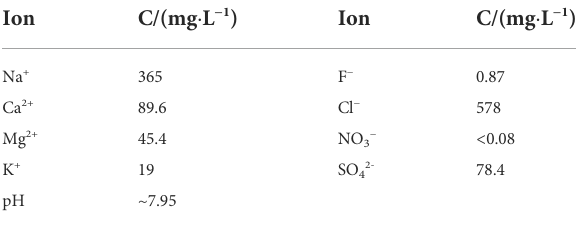
TABLE 1 Chemical composition of the groundwater taken from the Gansu proposed-treatment plant